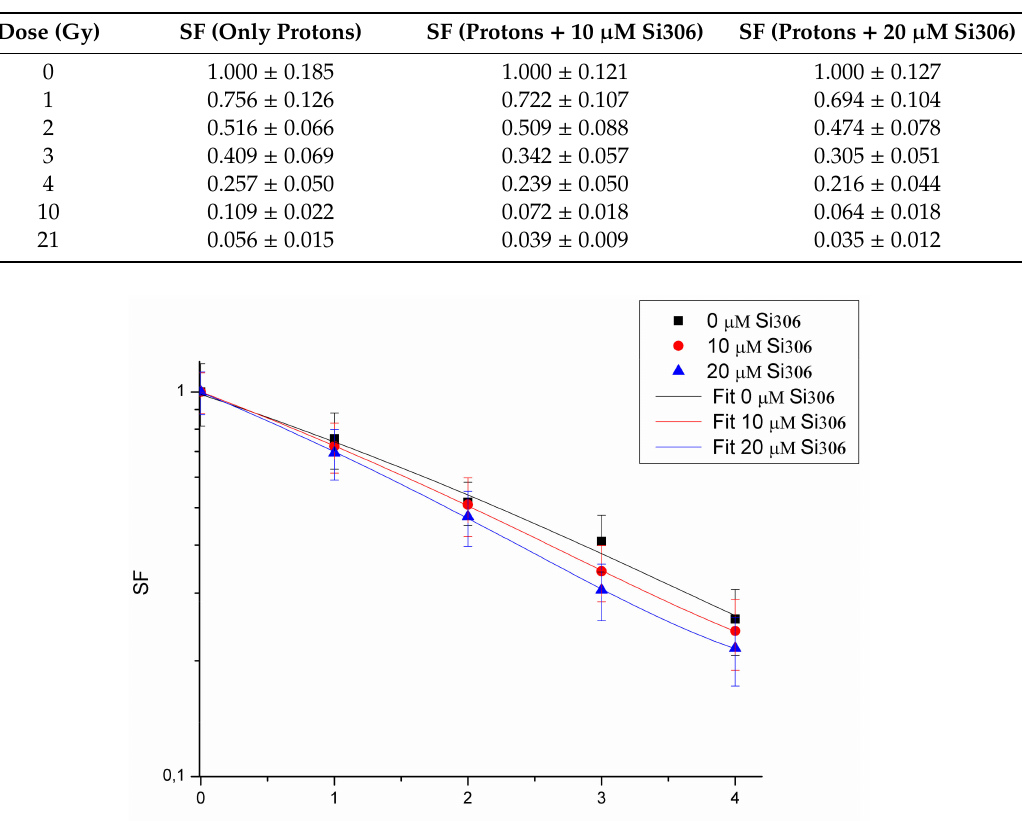
Table 2. Surviving fraction (SF) values of U87 cells after irradiation with only protons and after combined treatments with 10 and 20 µ M of Si306.